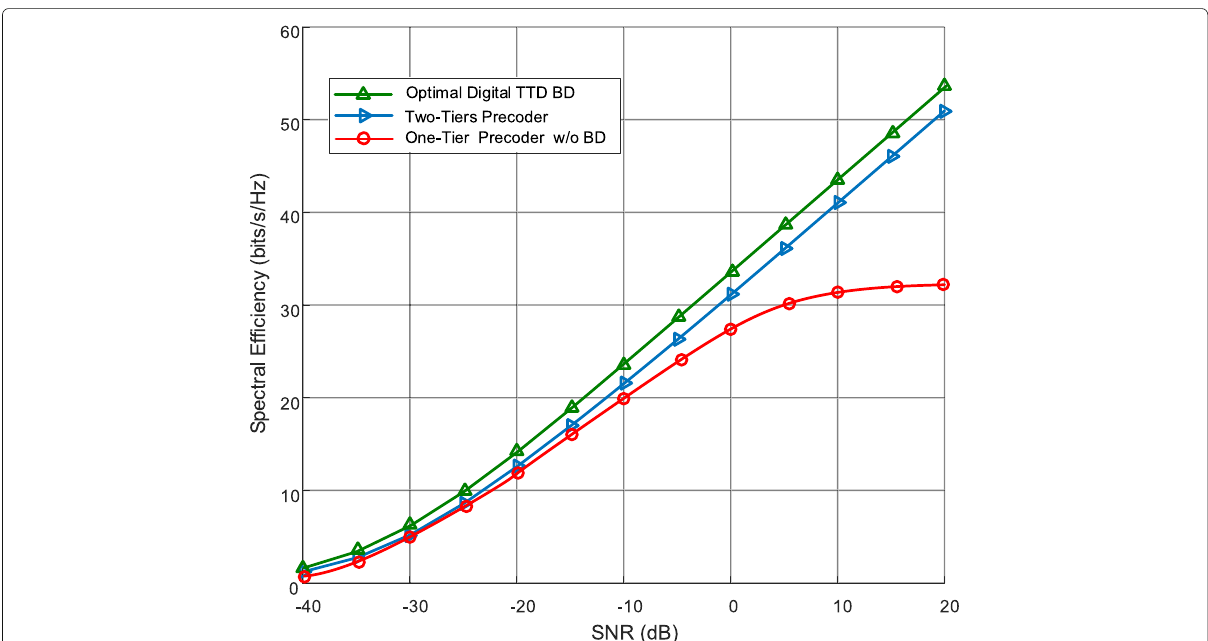
Fig. 6 Spectral efficiency achieved by different precoding schemes in multiuser mmWave MIMO-OFDM systems with U = 4 users, N t = 256, N r = 16, total bandwidth B = 1.2 GHz, f c = 60 GHz, N t